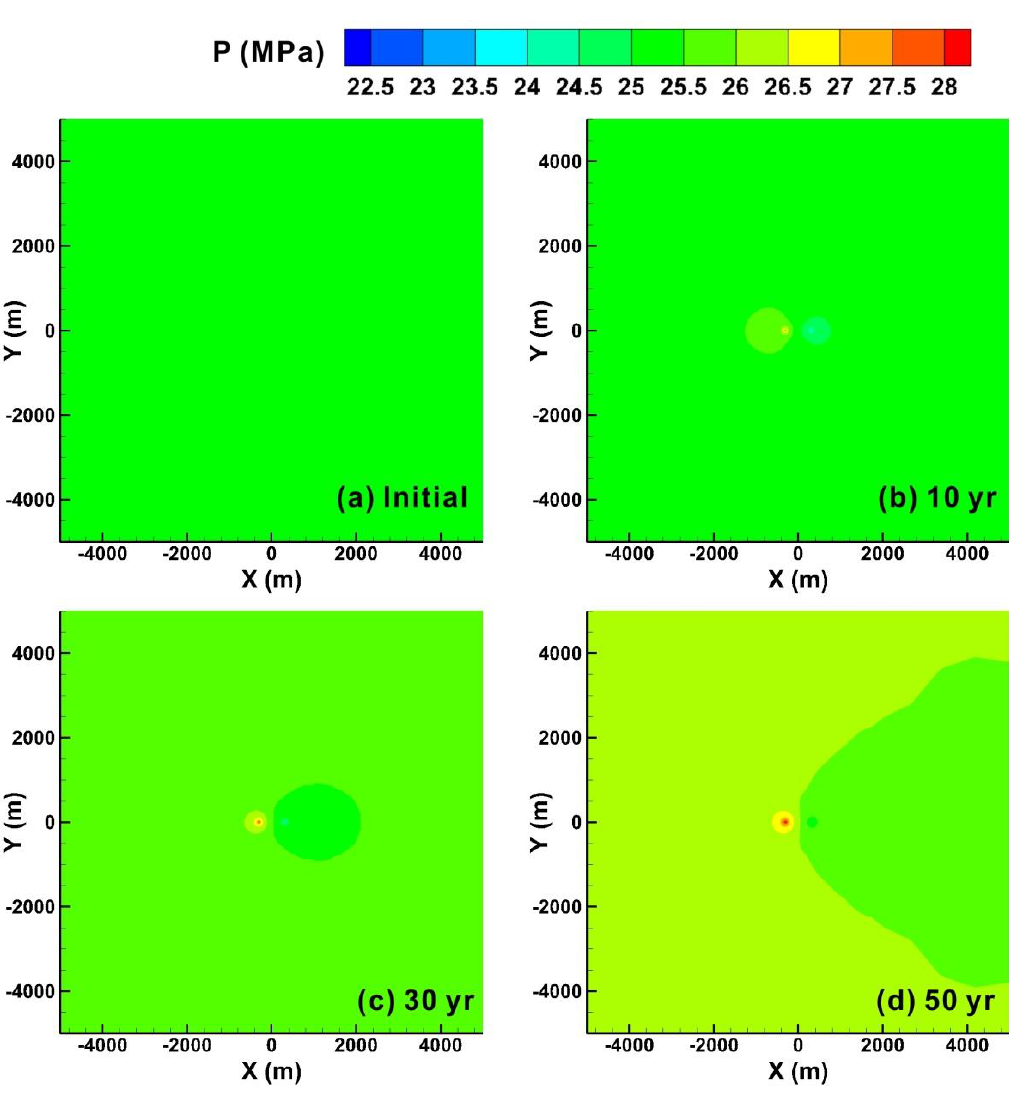
Figure 3. The reservoir pressure distribution at different times with the scheme of the different mass flow rate for injection (27.5 kg/s) and production (25.0 kg/s). The temperature distribution in the reservoir at different times is shown in Figure 4.